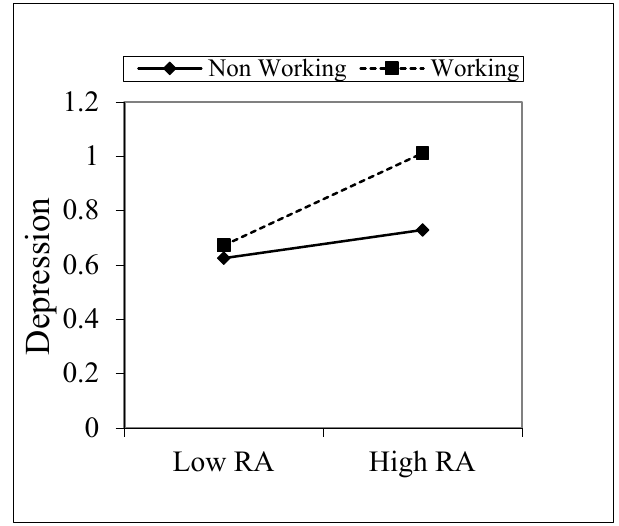
Figure 3. Moderation role of working St. between RA and depression.